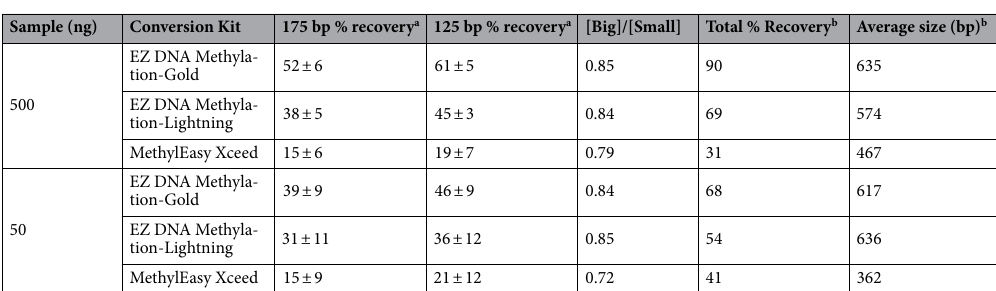
Table 2. Recovery and fragmentation of bisulfite kits using universal quantification 4-plex. a Combined average of qPCR and ddPCR of both assays of the same length; ± , standard deviation. b Estimate using Fragment Calculator